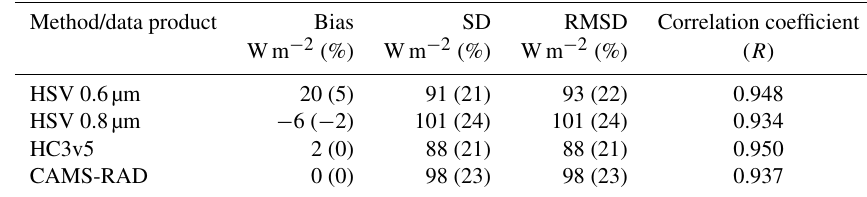
Table 5. Comparison between validation results of HSV and those of HC3v5 and CAMS-RAD, each one versus BSRN measurements. Statistics on 15min means of DSSI for the stack of 11 stations and the year 2011. N = 135107; BSRN mean=424Wm − 2 .